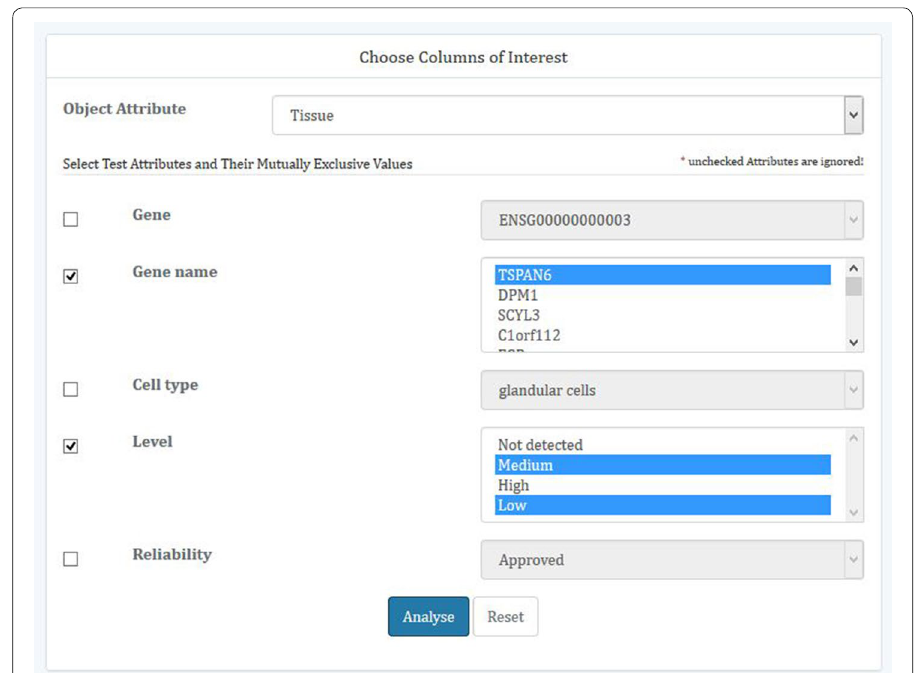
Fig. 1 Analysis of the normal tissue dataset by ConTra’s multiple attribute values